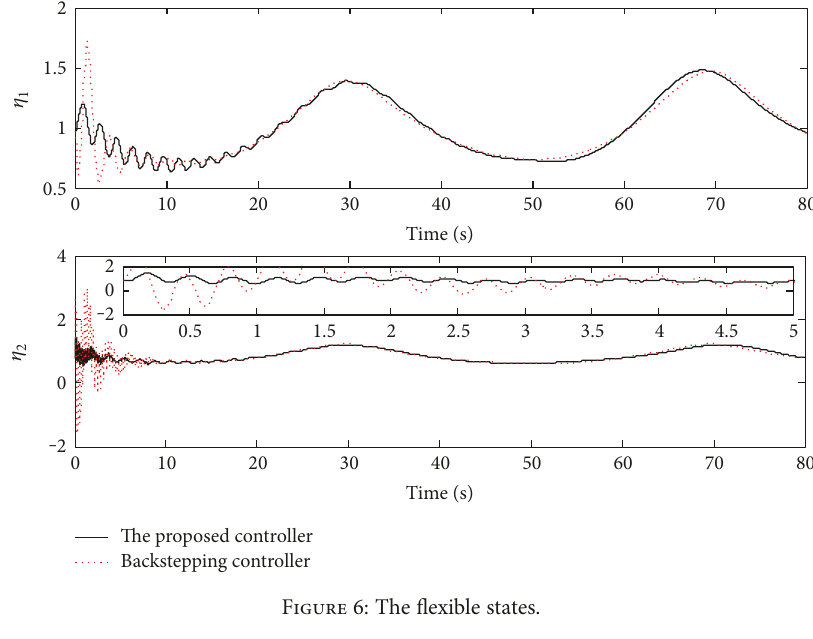
Figure 6: The fl exible states.